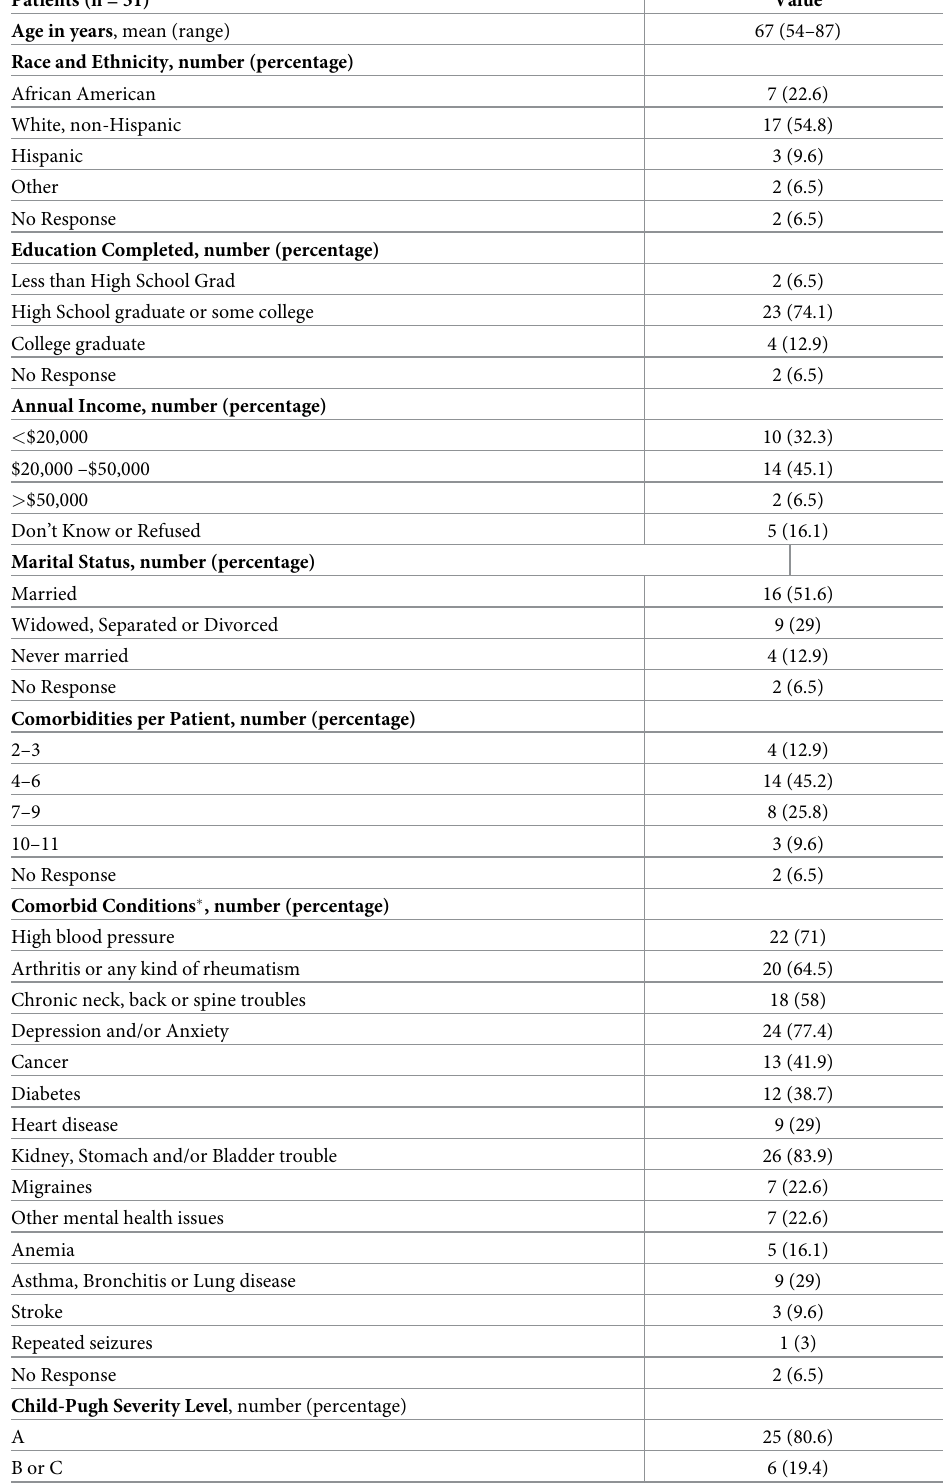
Table 1. Demographic characteristics of the study